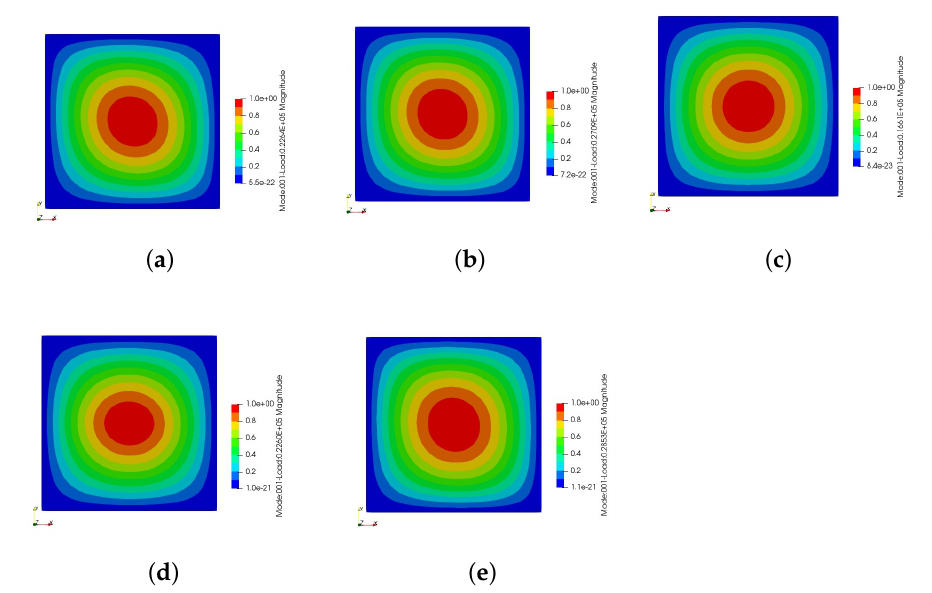
Figure 9. The first buckling modes in different laminates. ( a ) QI : 13.79 kN. ( b ) CS 1 : 16.51 kN. ( c ) CS 2 :